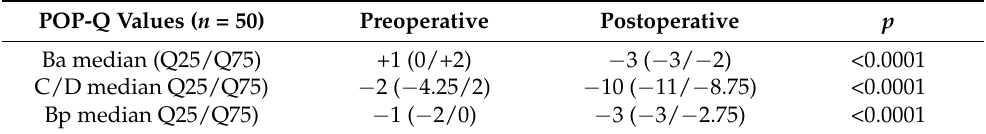
Table 3. POP-Q preoperative vs.